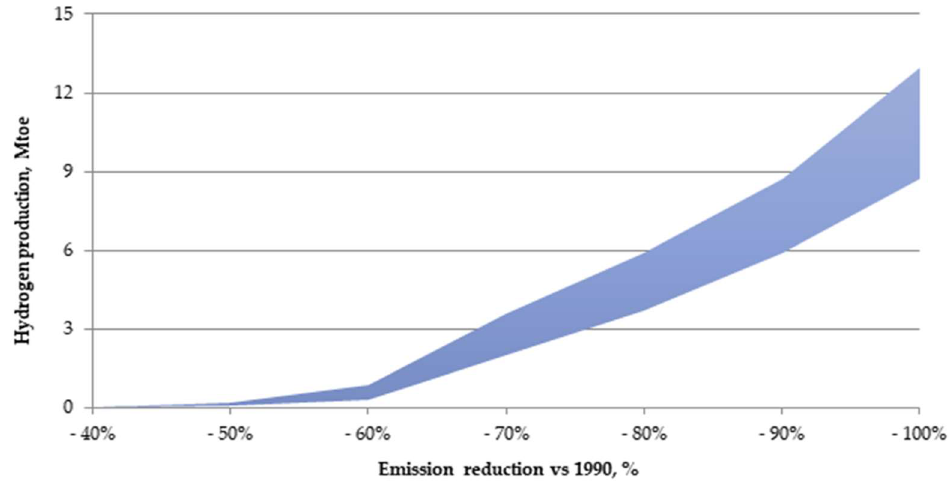
Figure 15. Production of hydrogen linked to the reduction of GHG emissions; Mtoe and %.